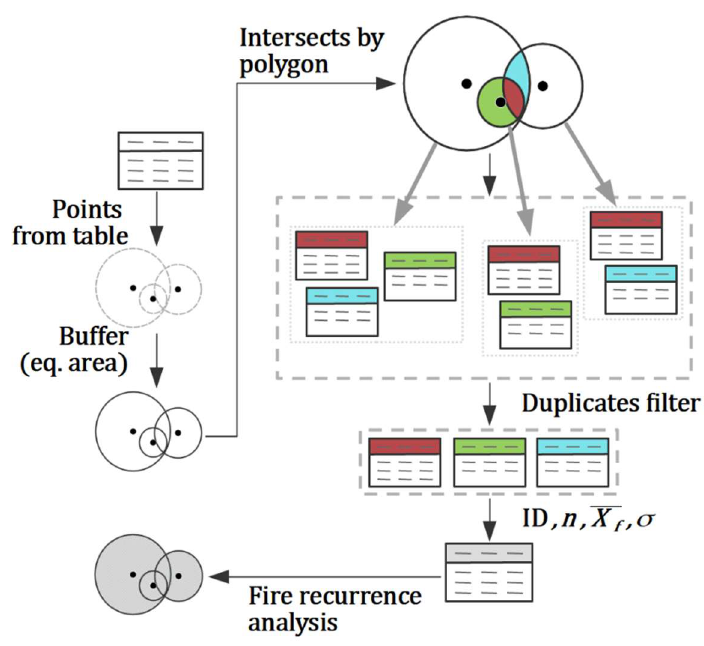
Figure 2. Flow diagram of the fire recurrence geographical analysis. Dashed boxes represent list objects, n = number of fires in the period or area of the intersecting polygons, and X ̅ f and σ are its average return interval and standard deviation, respectively. Detailed information is given in the Characterization of the fire regime components